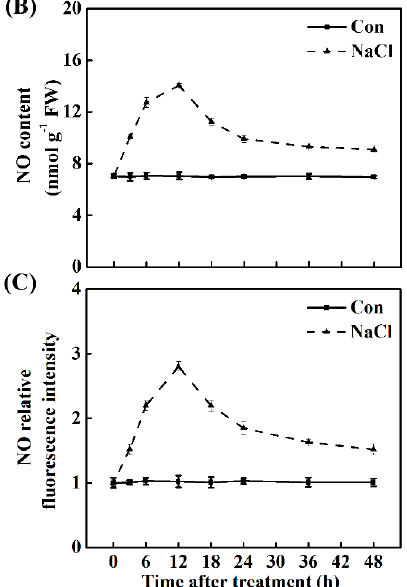
Figure 2. Changes in endogenous melatonin and nitric oxide (NO) levels in response to NaCl stress. Three-day-old rapeseed seedlings were transferred to 200 mM NaCl for 2 days. Meanwhile, melatonin ( A ) detected by enzyme-linked immunosorbent assay; and NO contents ( B ) determined by visible spectrophotography, and ( C ) determined by laser confocal scanning microscopy, and expressed as relative fluorescence intensity) in seedling roots were analyzed. The sample without chemicals was the control (Con). Values are means ± SE of three independent experiments with at least three replicates for each.